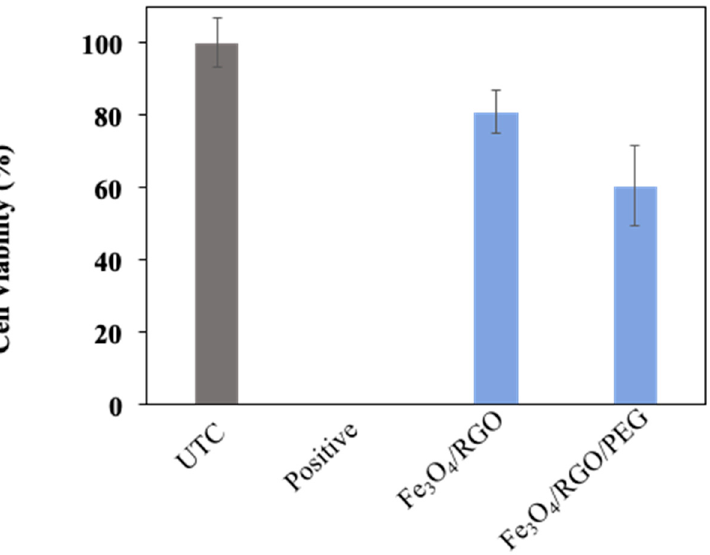
Figure 9. Cytotoxicity analysis of Fe 3 O 4 nanocomposites in HEK-2 normal cells (48 h incubation).